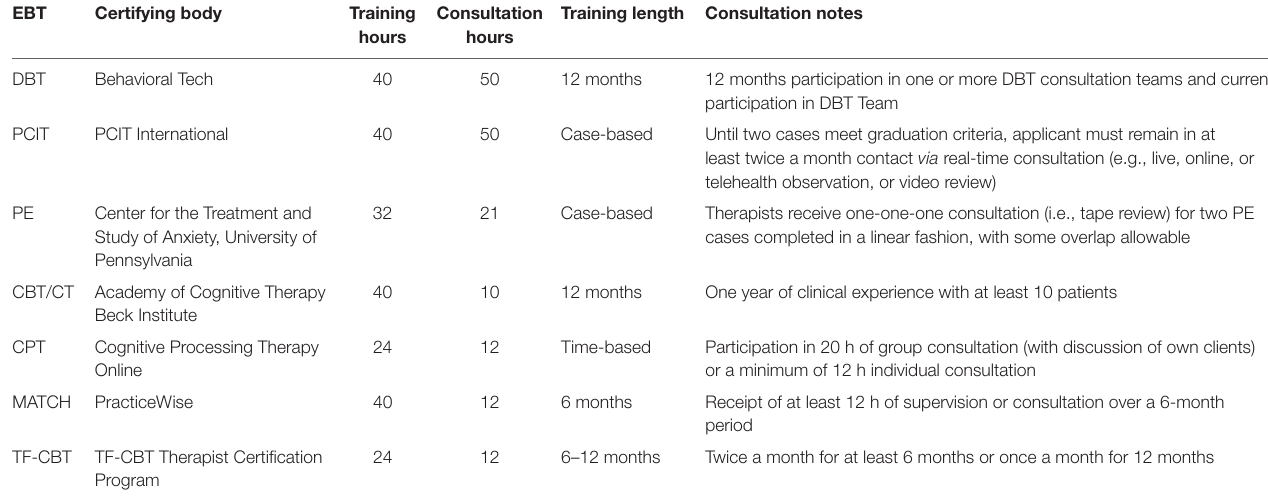
TaBle 1 | EBT training